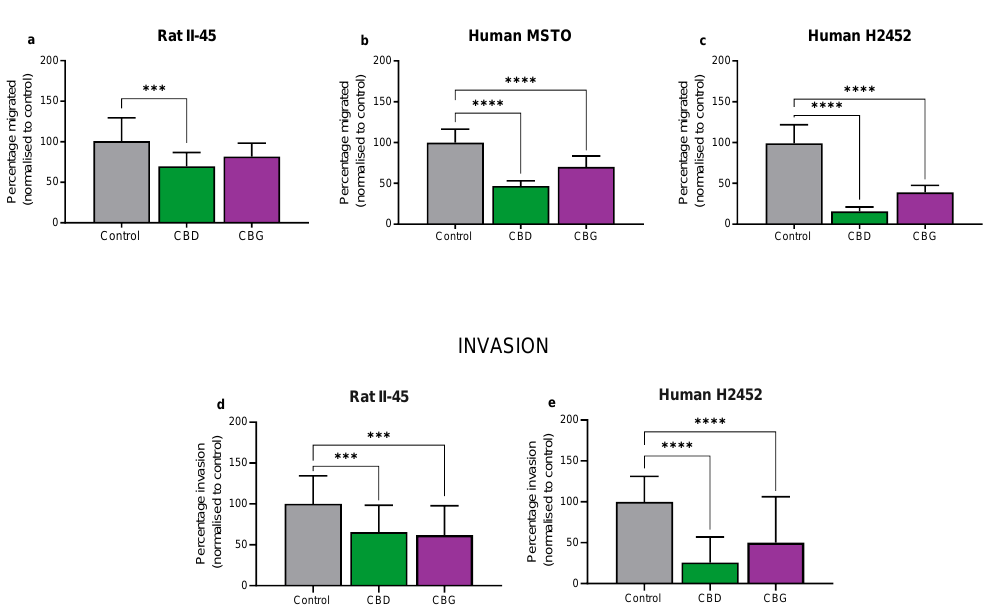
Figure 4. Cannabidiol (CBD) and cannabigerol (CBG) reduced migration and invasion of mesothelioma cell lines. Rat II-45 ( a , d ) and human MSTO ( b ) and H2452 ( c , e ) mesothelioma cell lines were examined with CBD and CBG being tested at sub-cytotoxic concentrations (2 µ M CBD for II-45, 6 µ M for MSTO and H2452 cells, and 10 µ M CBG for all cell lines). The number of migrated cells or cells that had invaded through the Matrigel per 5–10 fields of view was counted and analysed using CellProfiler. Bars show the mean and SD from three independent experiments. p -values were calculated using one-way ANOVA Kruskal-Wallis multiple comparisons. *** p < 0.001 and **** p < 0.0001 relative to vehicle treated control